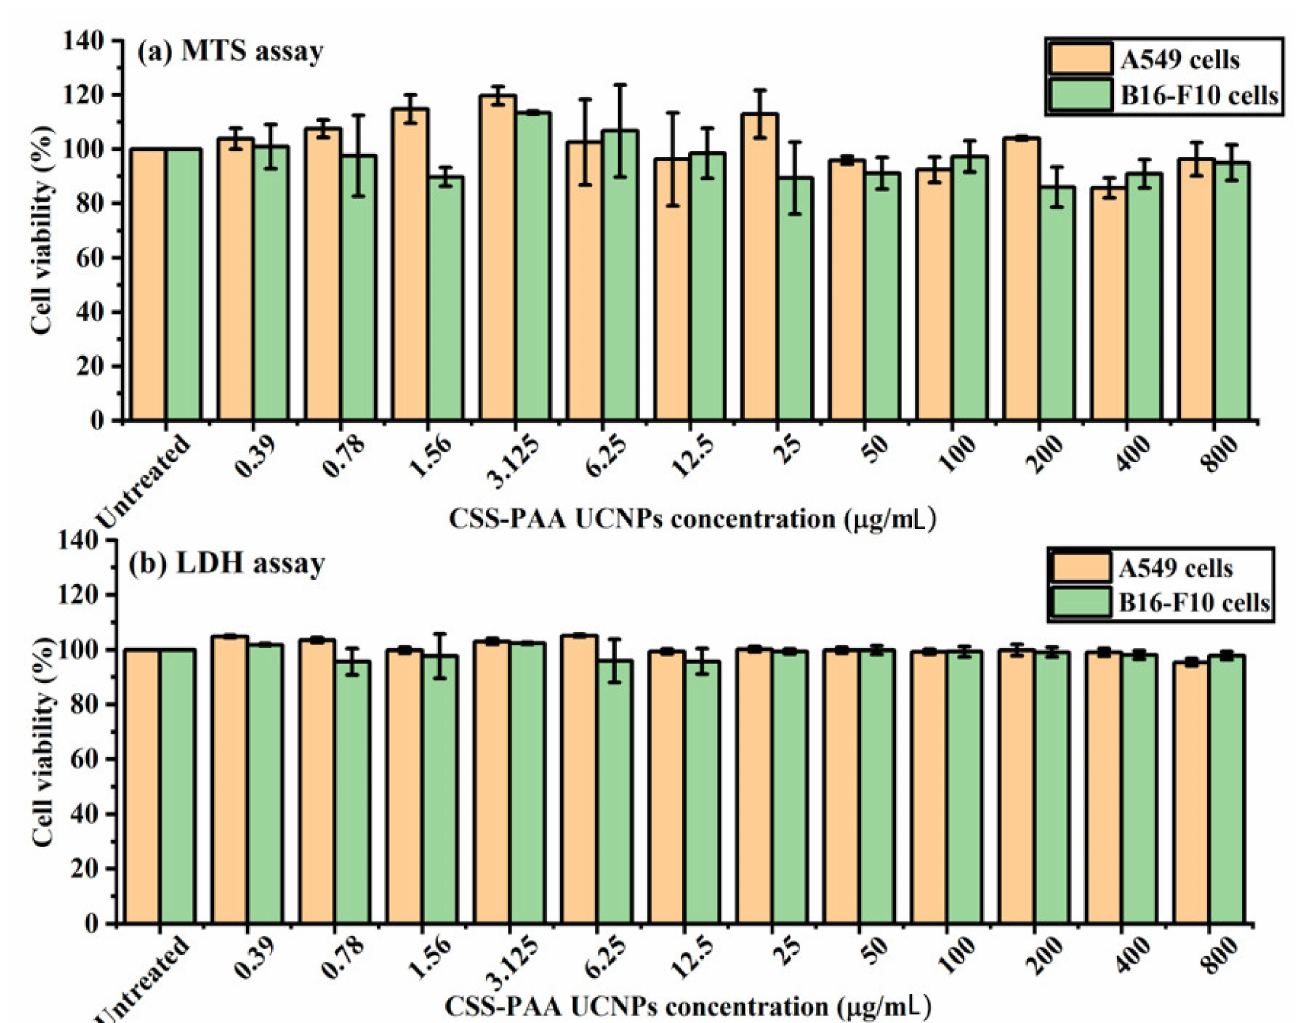
Figure 4. Cell viability of CSS-PAA UCNPs after incubation for 4 h with A549 and B16-F10 cells. These data are the results of ( a ) MTS and ( b ) LDH assays, which are expressed as cell viability (%) and presented as the mean ± SD (n =